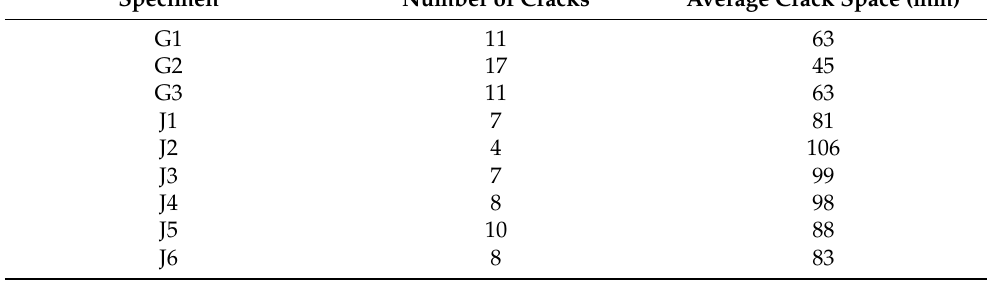
Table 5. Crack formation of the specimens.